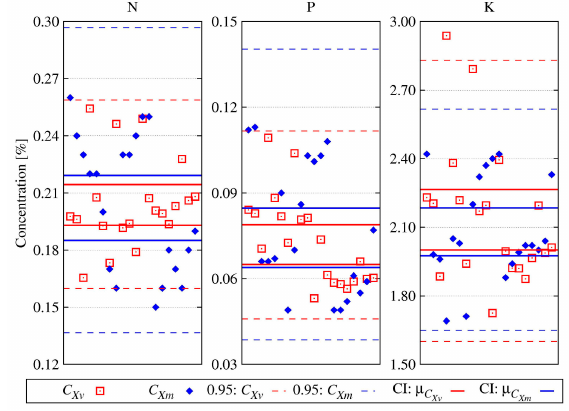
Figure 2. Graphical view of the statistical assessment of calculated ( C Xv ) and measured ( C Xm ) concentrations in sediments for X = N, P, or K.